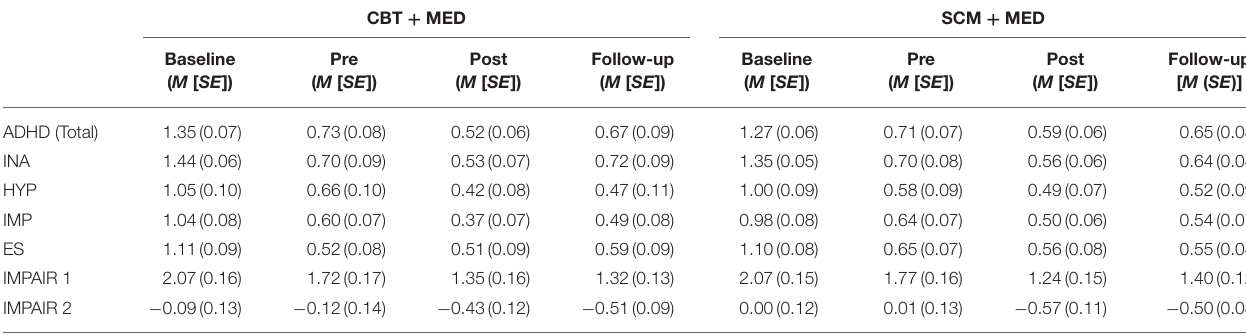
TABLE 3 | Mean (M) and standard error (SE) of ADHD symptoms and impairment at baseline pre, post, and follow-up evaluation.